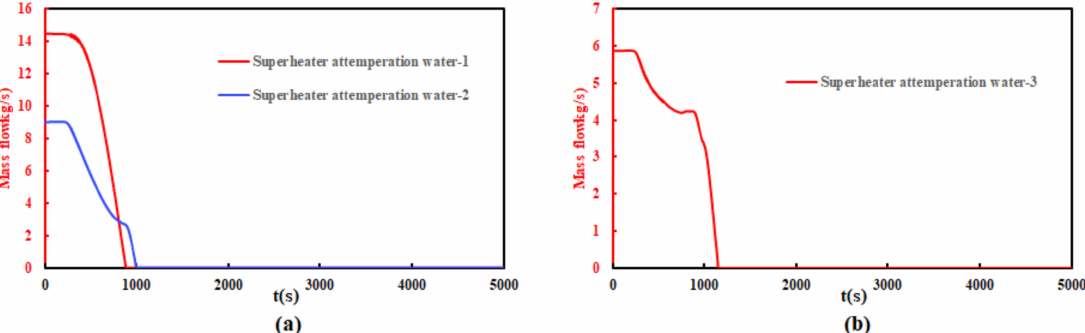
Figure 16. Attemperation water system response when coal mass flow decreased by 5%: ( a ) super- heater attemperation water-1 and superheater attemperation water-2 mass flow; ( b ) superheater attemperation water-3 mass